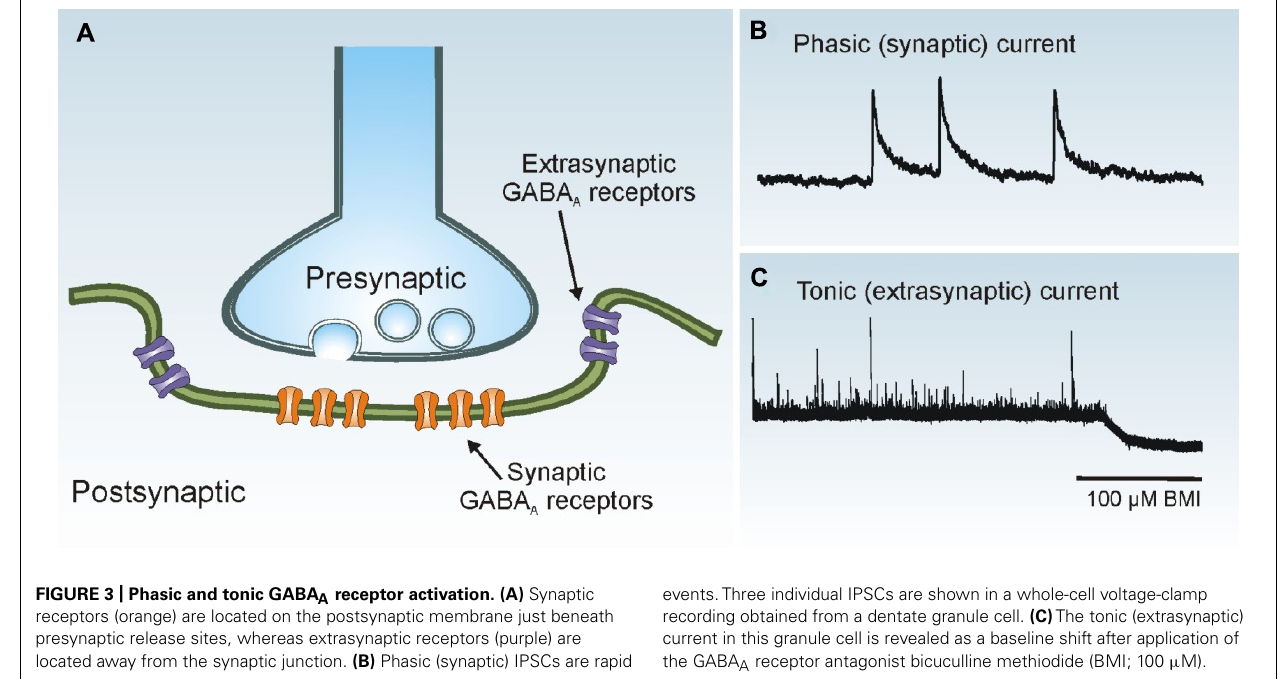
FIGURE 3 | Phasic and tonic GABA A receptor activation. (A) Synaptic receptors (orange) are located on the postsynaptic membrane just beneath presynaptic release sites, whereas extrasynaptic receptors (purple) are located away from the synaptic junction. (B) Phasic (synaptic) IPSCs are rapid